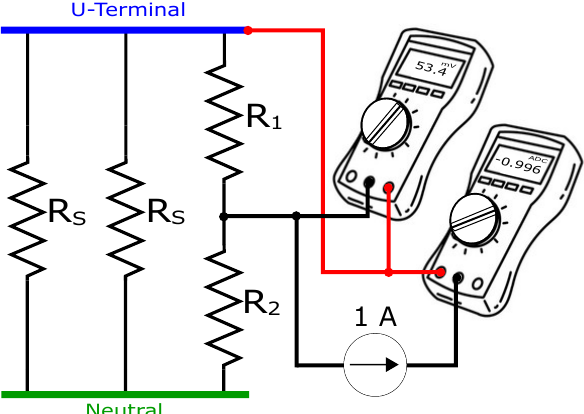
Figure 7. Sketch illustrating the setup for accurate resistance